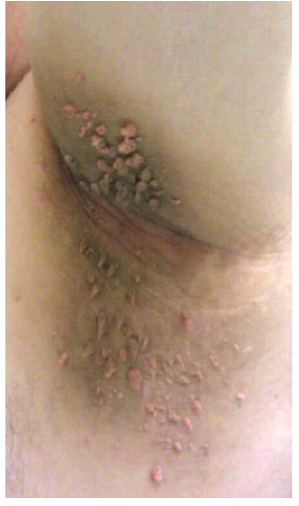
Figure 2: Anterior view of the left